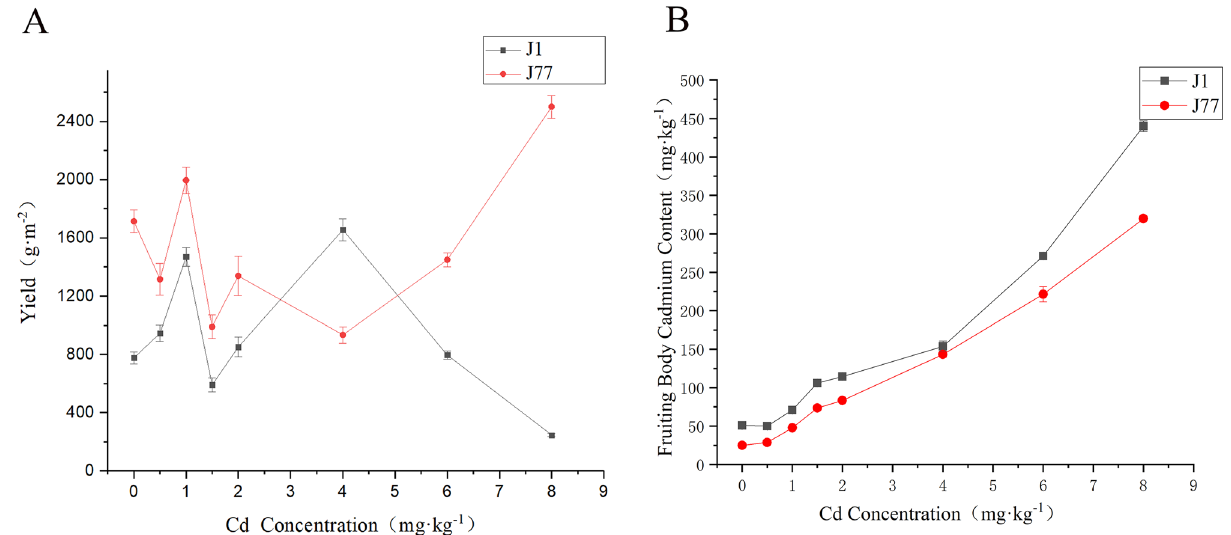
Figure 2. Effects of Cd stress on yield and Cd content in fruiting